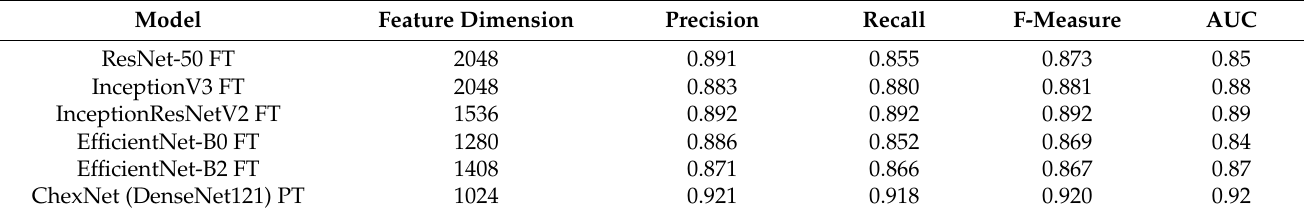
Table 1. Performance evaluation of various feature extractors for image-based prediction.